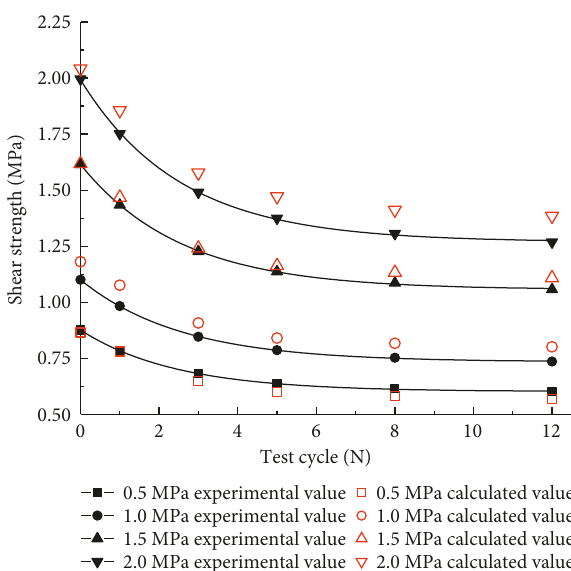
Figure 14: Comparison between test and calculated valves of joint surface’s shear strength under heat-wet